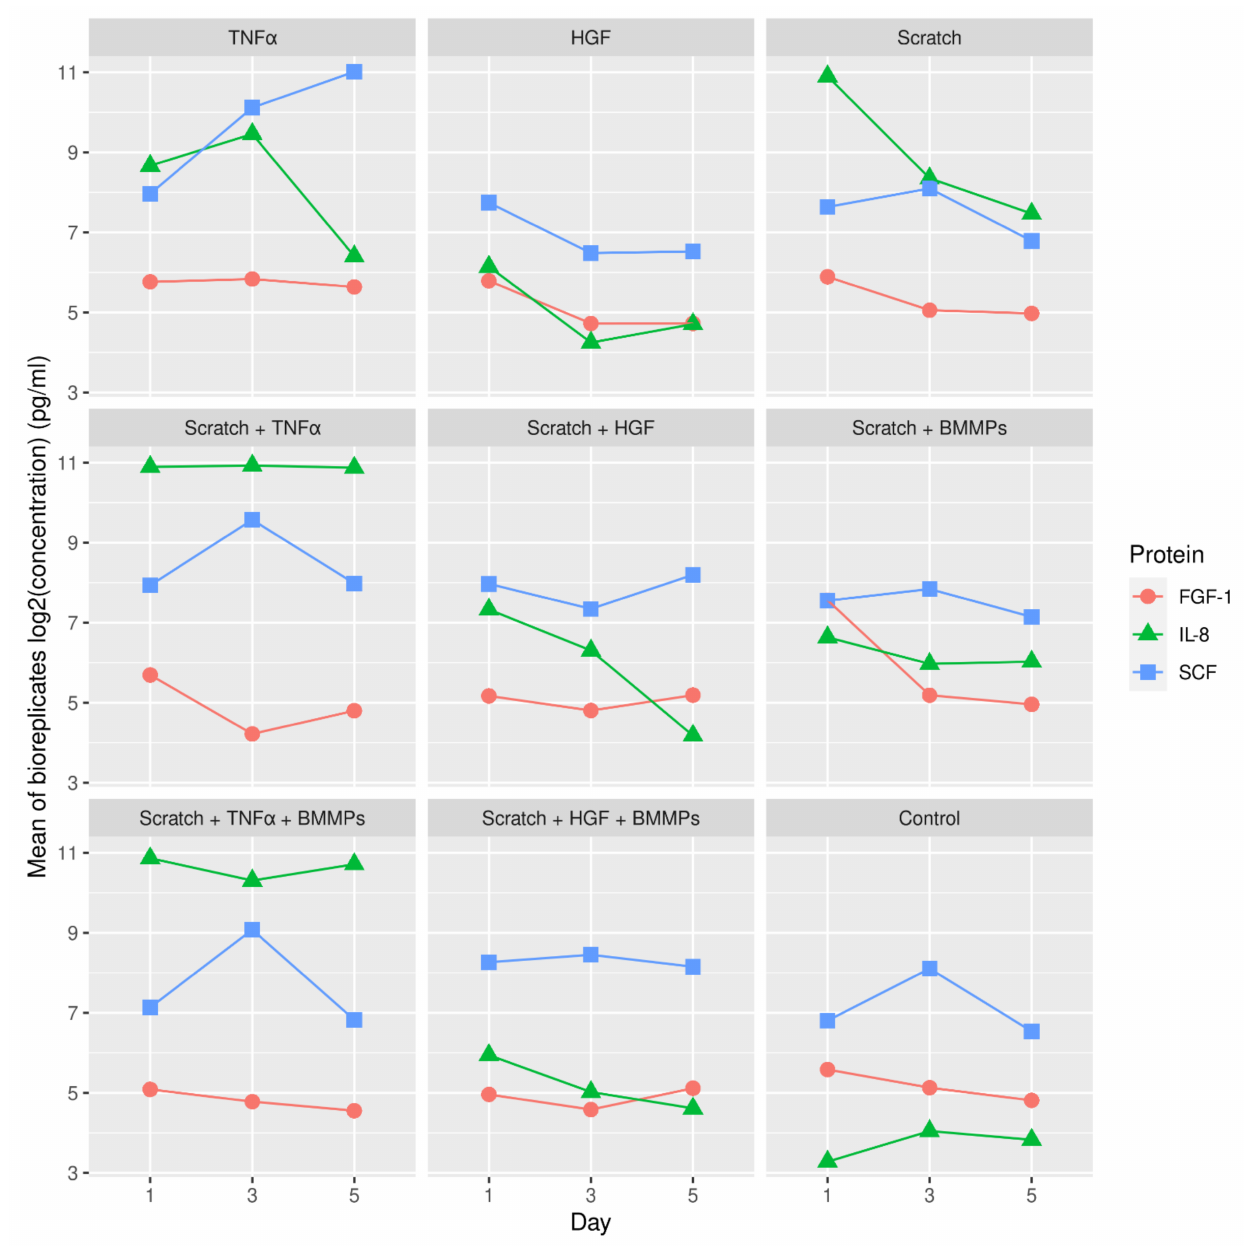
Figure A3. Log2 concentration in pg/mL of mean of biological replicates for FGF-1, IL-8, and SCF protein for the three different time